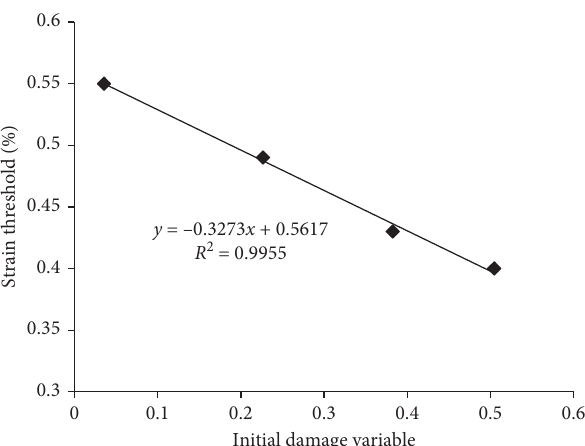
Figure 10: Relationship between the initial damage and the strain threshold of creep failure in the creep